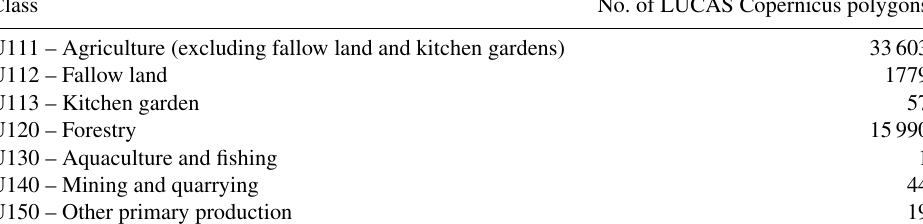
Table A2. LUCAS Copernicus level-3 land use